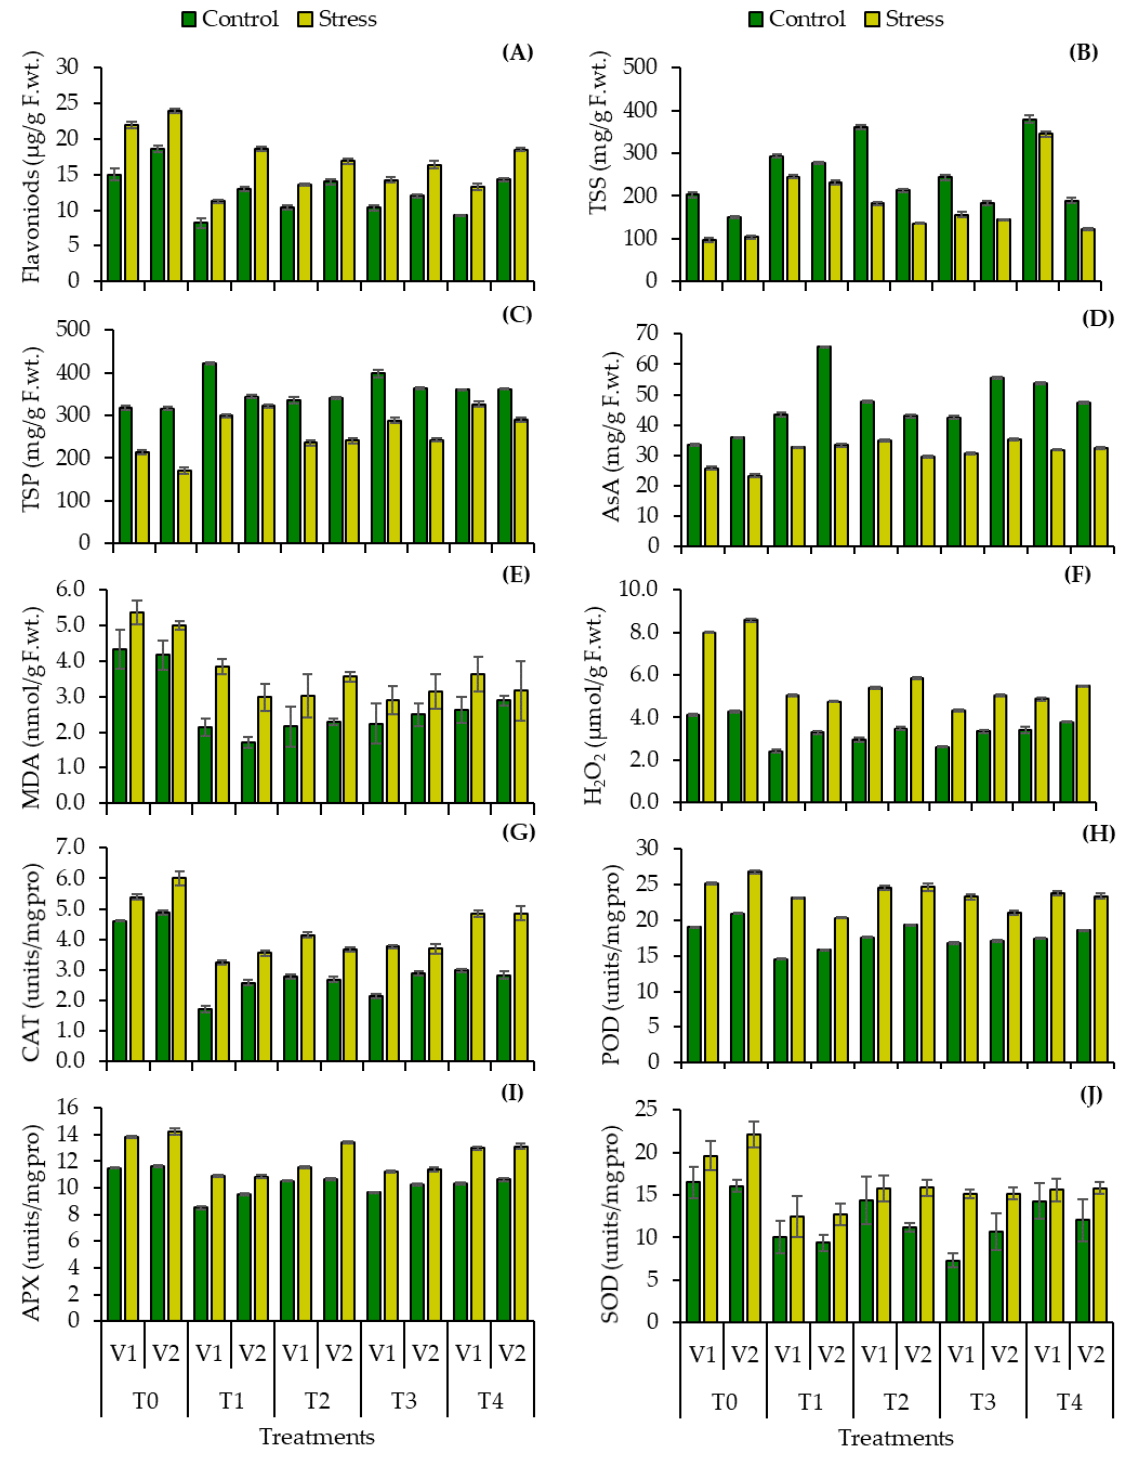
Figure 4. ( A ) Flavonoids, ( B ) total soluble sugars, ( C ) total soluble proteins and ( D ) ascorbic acid ( E ) malonaldehyde, ( F ) hydrogen peroxide contents ( G ) catalase, ( H ) peroxidase, ( I ) ascorbate peroxi- dase, and ( J ) superoxide dismutase enzyme activity of two cultivars of maize ( Zea mays L.) inoculated with Bacillus spp. strains subjected to water stress condition (Mean ± S.E). Here, T0 = uninoculated control, T1 = Bacillus cereus strain BEB1, T2 = Bacillus cereus strain BEB2, T3 = Bacillus tropicus strain BEB3, T4 = Bacillus thuringiensis strain BEB4. LSD ≤